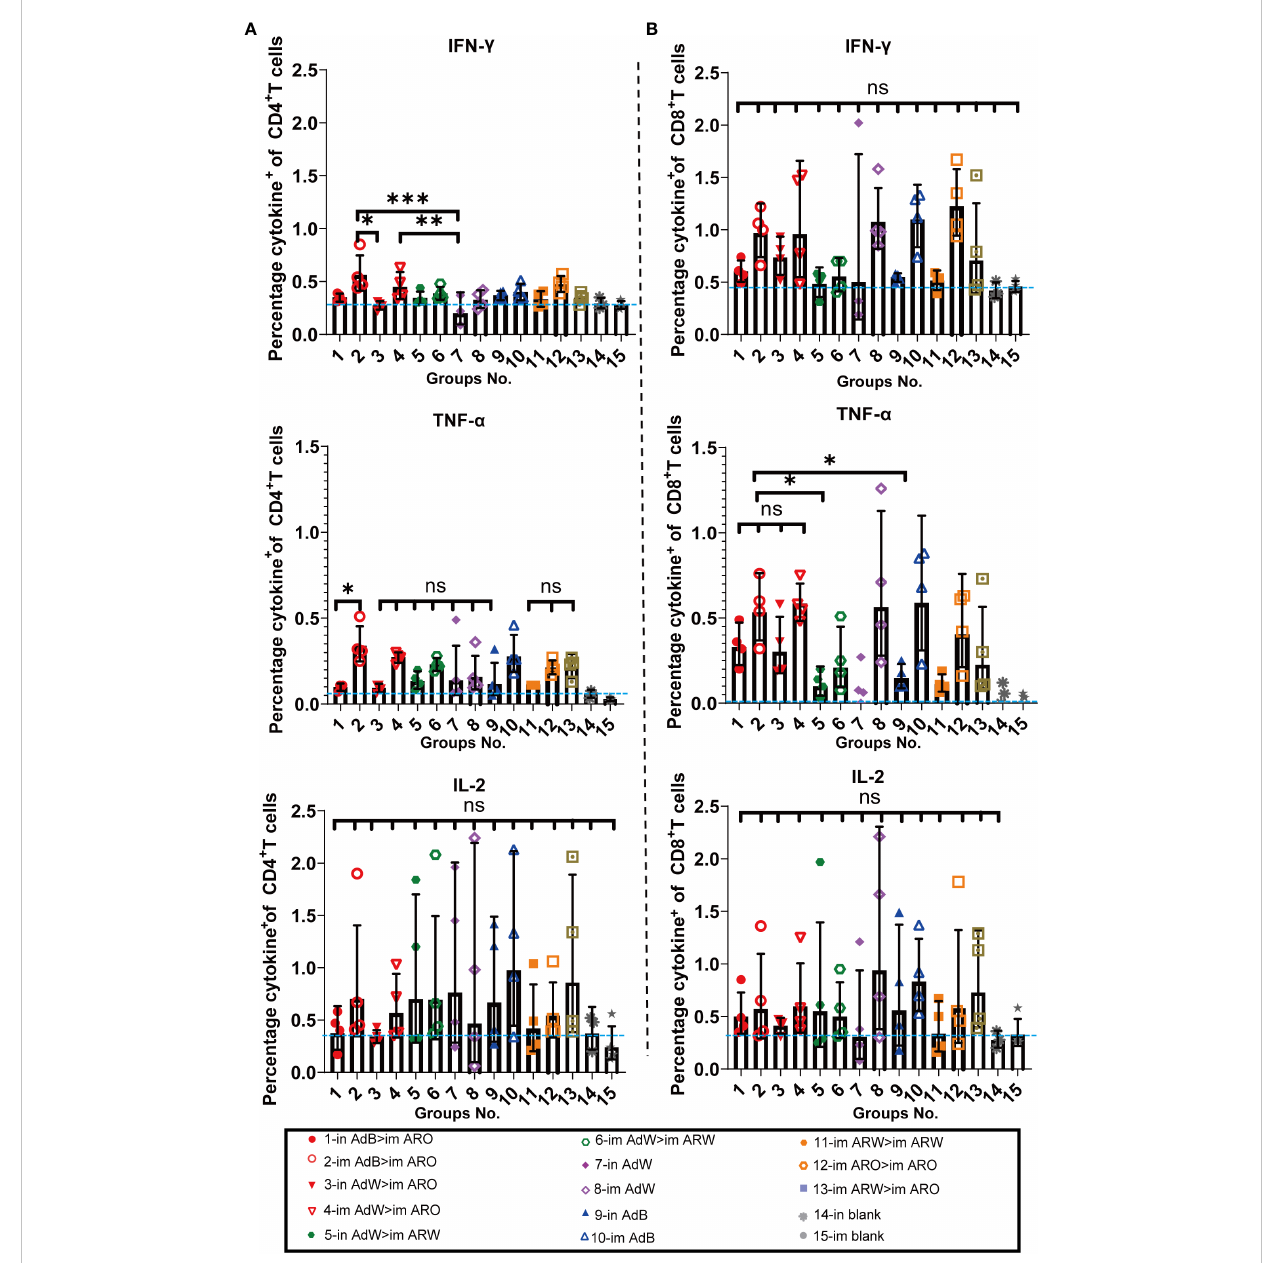
FIGURE 9 Th1/Th2 skewing was detected via intracellular cytokine staining on day 49 after primary immunisation. Percentage of spike protein-speci fi c IFN- g -, IL-2-, and TNF- a -positive memory (A) CD4 + T and (B) CD8 + T cells was measured on day 49 after primary immunisation (n = 4 per group; each point represents one sample). Bars represent the geometric mean ± geometric SD; *P < 0.05; **P < 0.01; ***P < 0.001; ns, P > 0.05. The blue dashed lines represent the blank